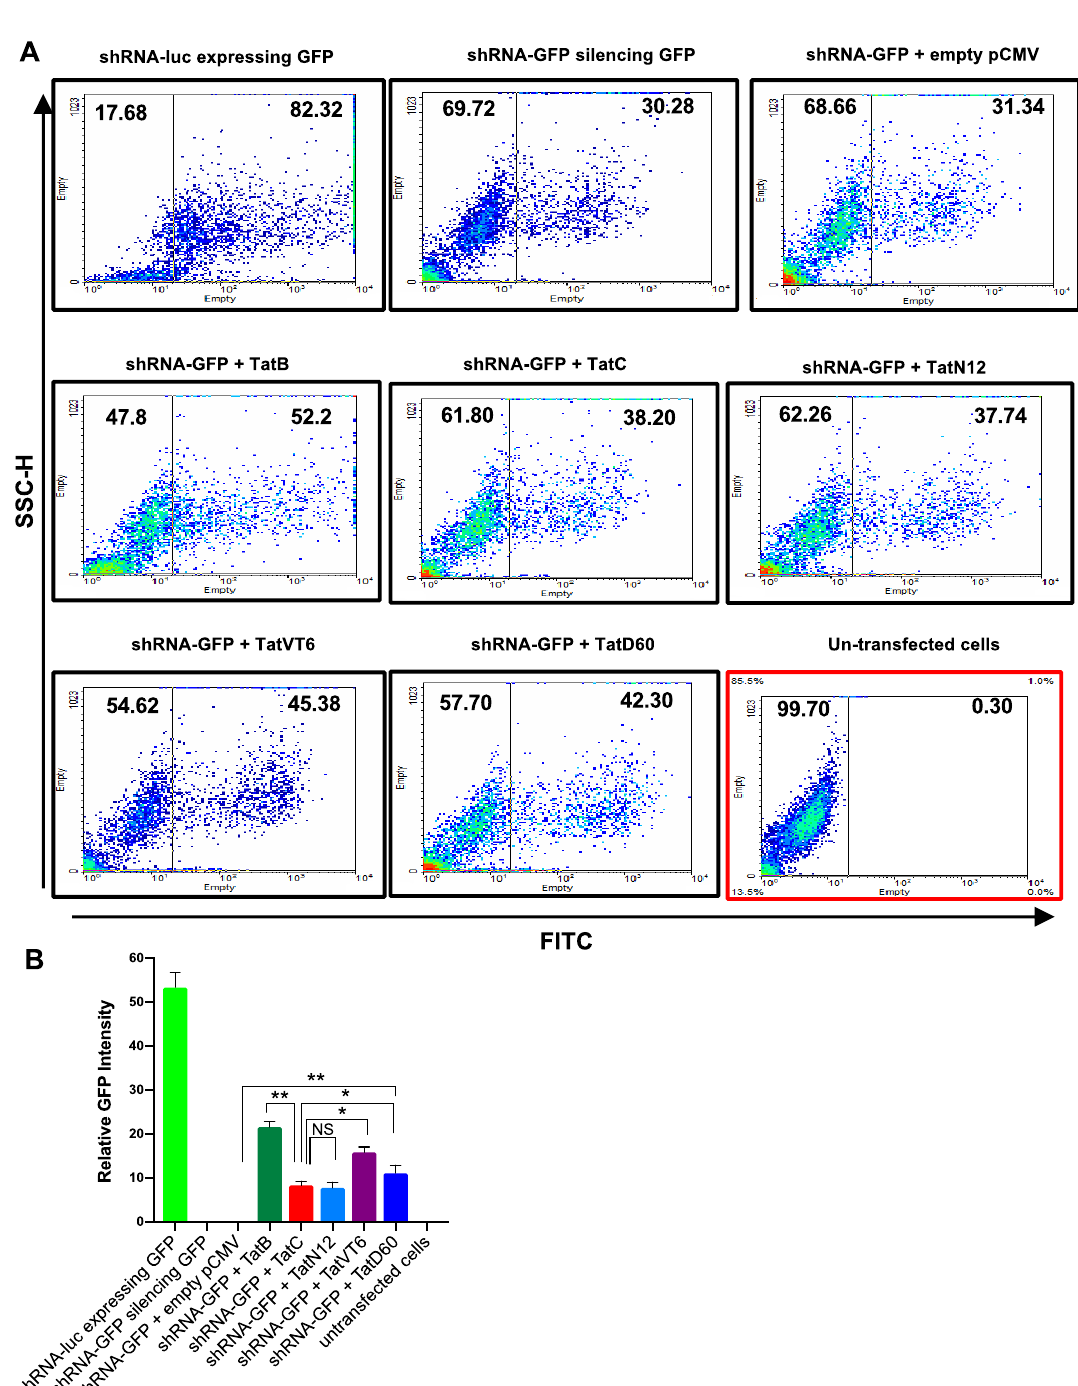
Figure 2. A short hairpin RNA (shRNA) suppressor activity of Tat variants and subtypes by flow-cytometry. Panel ( A and B ) HEK293T cells (1 µ g plasmid DNA / well in 1 × 10 6 cells) were co-transfected with shRNA-GFP (0.5 µ g in 1 mL) and Tat variants (TatN12 or TatVT6 or TatD60) or Tat subtypes (TatB or TatC) or empty pCMV-Myc vector. The 1:1 ratio of shRNA-GFP and Tat constructs was used for transfection. After 24 h of transfection, cells were counted for GFP-expressing cells by flow-cytometry (BD-LSRII) using the Green Fluorescent Protein (GFP) under Fluorescein isothiocyanate (FITC) channel versus a Side Scatter-Height (SSC-H). The flow data was analyzed using FlowJo 10.3 software. In the plot, the x-axis represents FITC (GFP) and the y-axis represents SSC-H. The relative GFP intensity of Tat variants was calculated by normalizing with the expression of empty pCMV-Myc vector. The un-transfected cells were used as a control to make gating for the